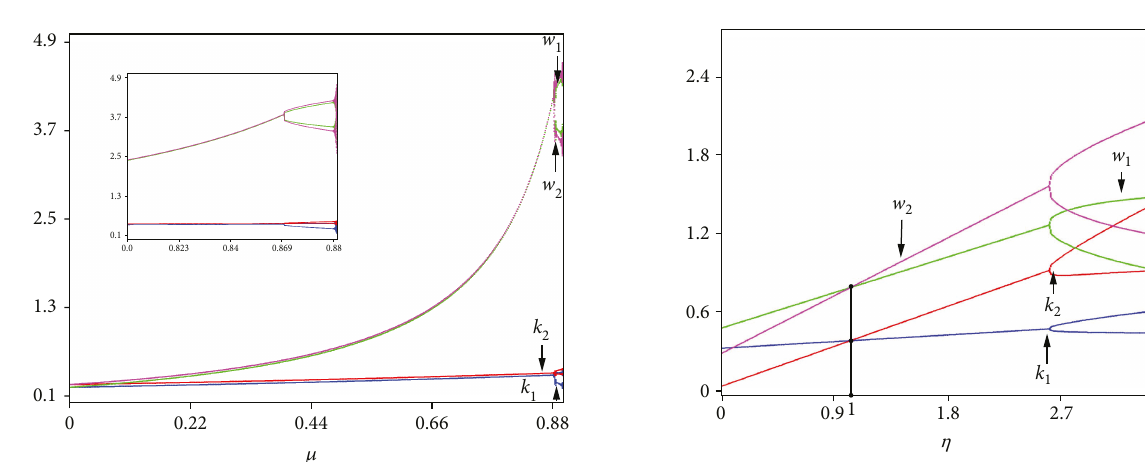
Figure 14: Bifurcation diagram of k